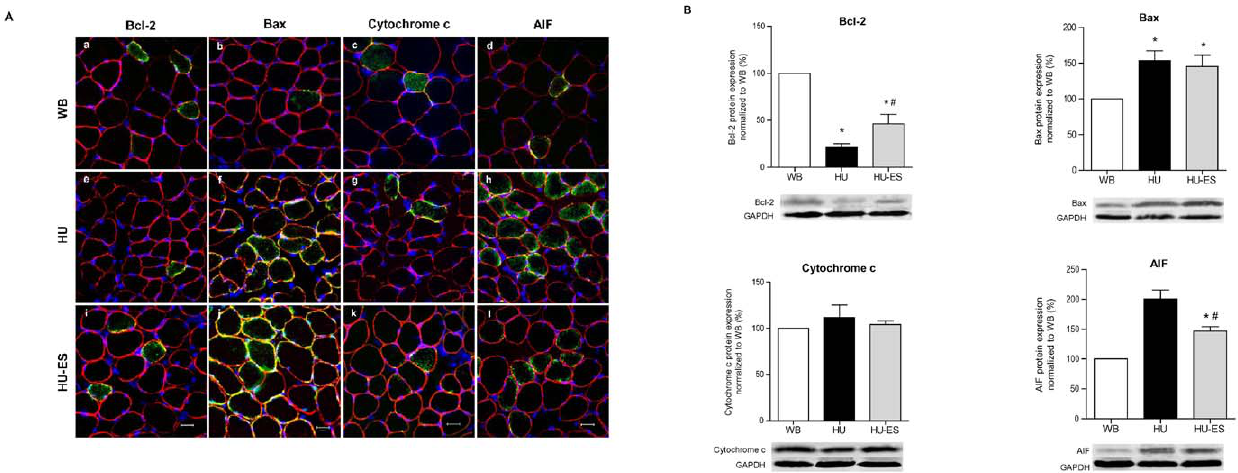
Figure 5. Bcl-2, Bax, cytochrome c, and AIF of the soleus muscle in the weight-bearing (WB), hindlimb-unloaded (HU), and electrically stimulated (HU-ES) groups. (A) Immunohistochemically stained cross-sections showing expression of Bcl-2, Bax, cytochrome c, and AIF (all in green) counterstained with antibodies against dystrophin (red) for myofiber identification and DAPI (blue) for nuclei visualization. Scale bar=25 m m. (B) Western blot analysis of expression of Bcl-2, Bax, cytochrome c, and AIF relative protein levels normalized to WB group. Representative immunoreactive bands were shown. *p , 0.05, significant difference compared to WB group; # p , 0.05, significant difference compared to HU group. Values are means 6 SEM.